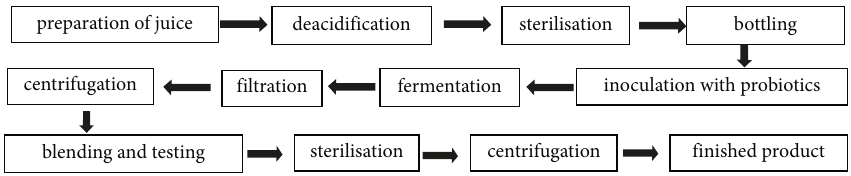
Figure 1: The main steps of this